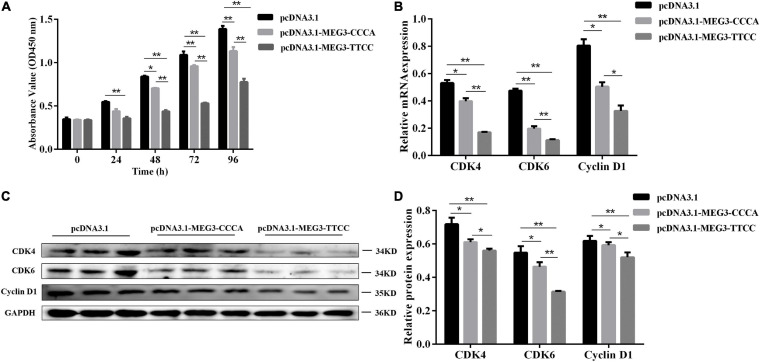
MEG3 haplotypes overexpression suppressed proliferation of SCs. (A) Cell proliferation was measured by CCK-8 at 48 h after transfection of pcDNA 3.1 (+), pcDNA3.1-MEG3-CCCA or pcDNA3.1-MEG3-TTCC in SCs. (B) The mRNA expression of proliferation-related genes in pcDNA 3.1 (+), pcDNA3.1-MEG3-CCCA or pcDNA3.1-MEG3-TTCC groups by qRT-PCR analysis. (C,D) Detection and expression level of proliferation-related protein in pcDNA 3.1 (+), pcDNA3.1- MEG3-CCCA, or pcDNA3.1-MEG3-TTCC groups by western blot assay. The significance test: *P < 0.05, **P < 0.01.